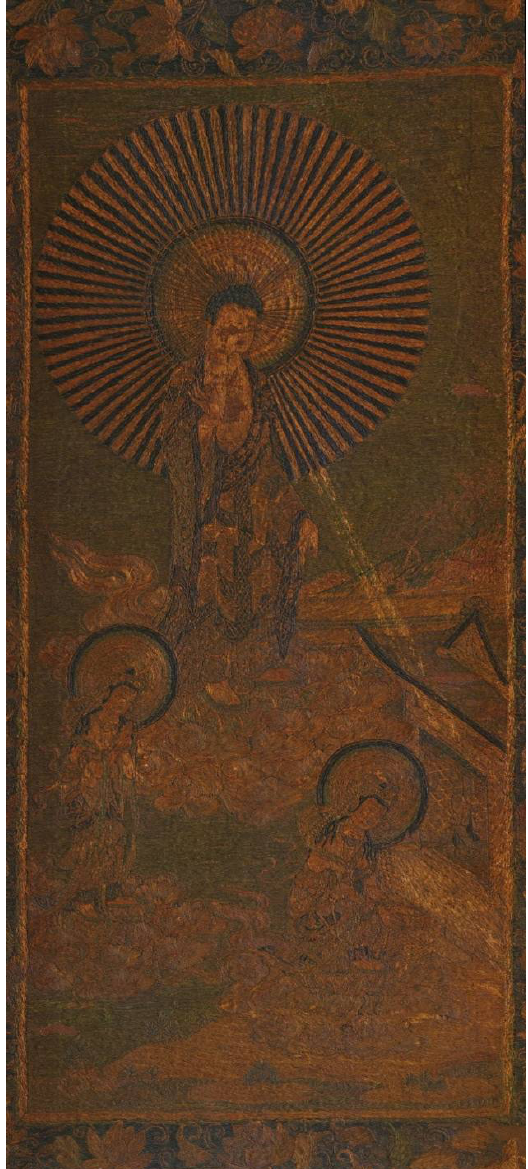
Figure 2. Descent of Amida Triad, 14th–15th century, Hair and silk thread embroidery on plain weave silk, Shōchi’in, Wakayama Prefecture, Height: 58.4 cm, Width: 26.2 cm. Source: Ito no mihotoke , Nara National Museum (Nara: Nara National Museum, 2018, 86).